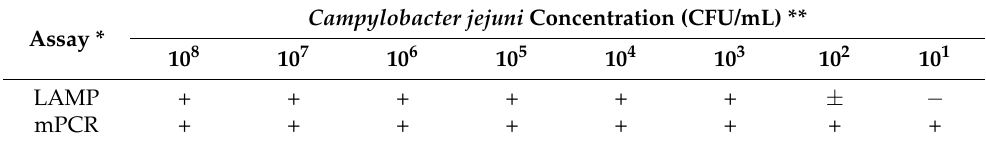
Table 7. Sensitivity test of LAMP and mPCR assays at different concentrations of C. jejuni .